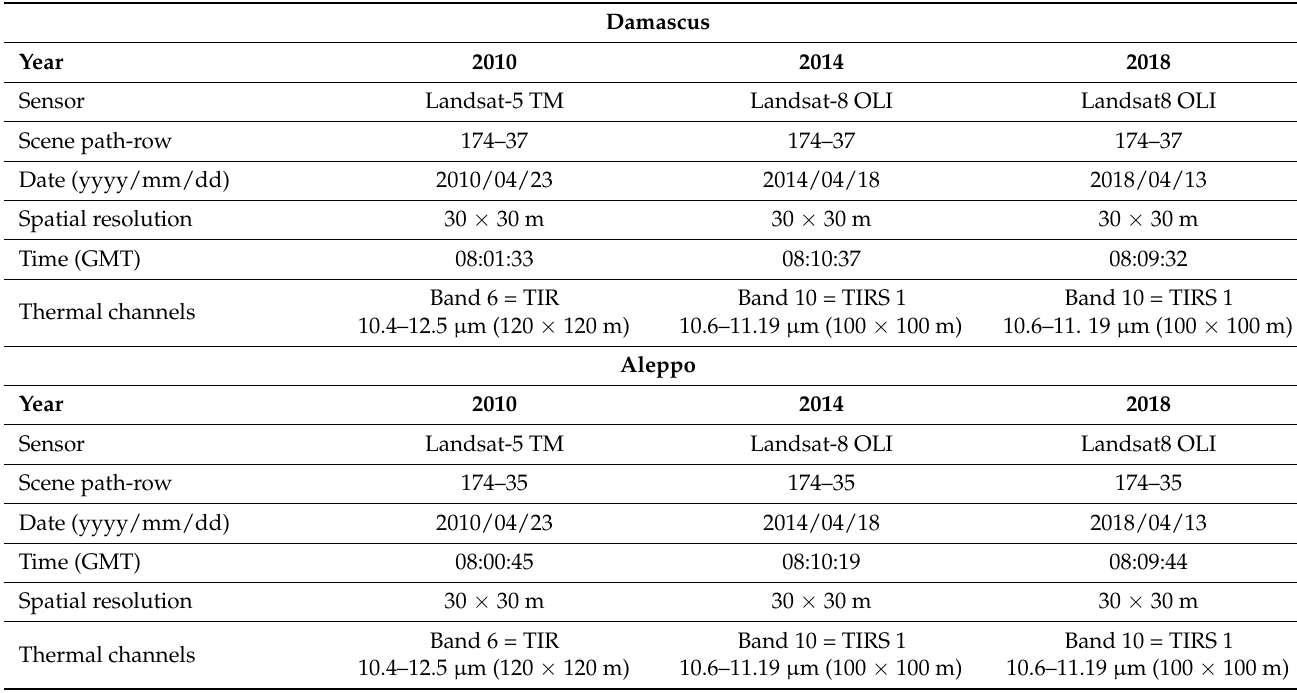
Table 1. Characteristics of Landsat-5 Thematic Mapper (TM) and Landsat-8 operational land imager (OLI) images used in the study